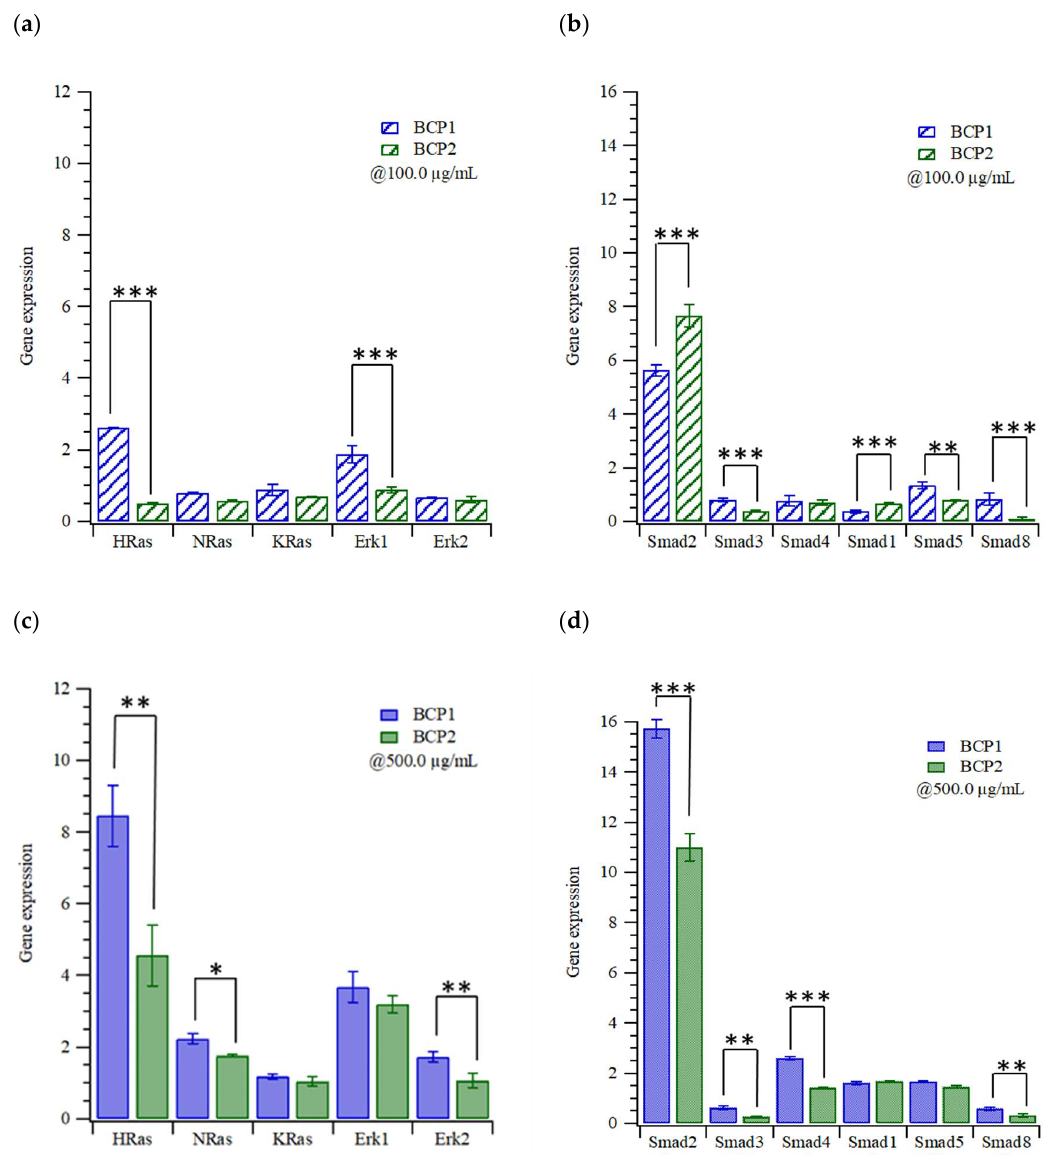
Figure 5. Expression levels of ( a , b ) Ras and ERK or ( c , d ) Smads in iPSCs exposed to ( a , b ) 100 and ( c , d ) 500 µ g/mL of BCPs (relative to unexposed controls) (* p < 0.05; ** p < 0.005; *** p < 0.0005).